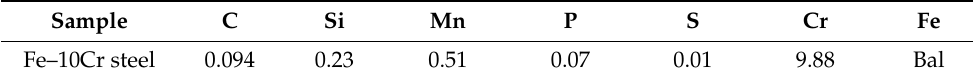
Table 1. Chemical composition of Fe-10Cr steel